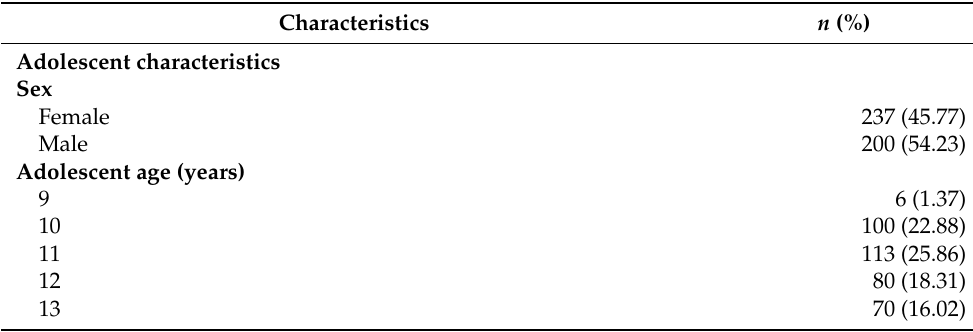
Table 1. Baseline characteristics of adolescents and caregivers in the B’More Healthy Community for Kids (BHCK) trial